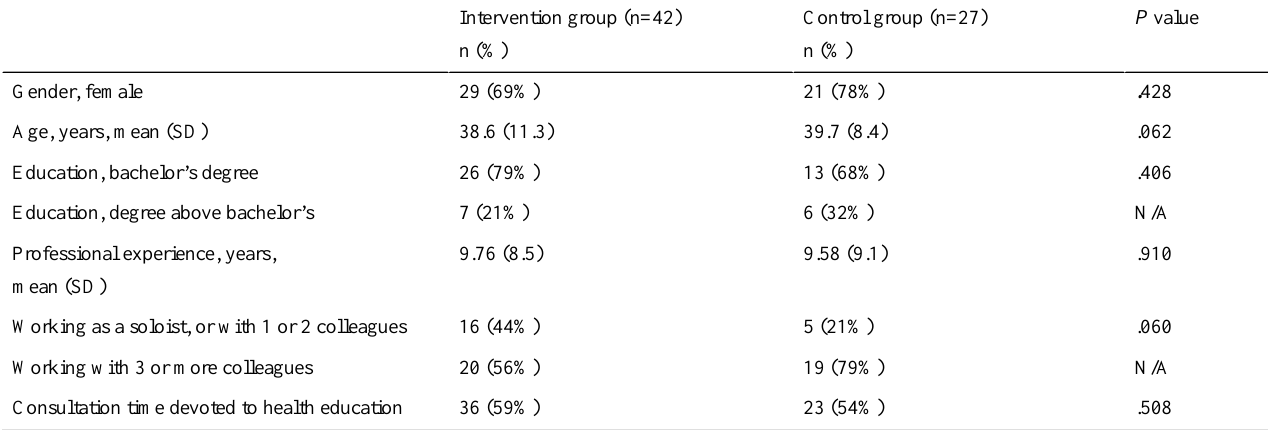
Table 1. Baseline demographics of study participants ( N = 69).